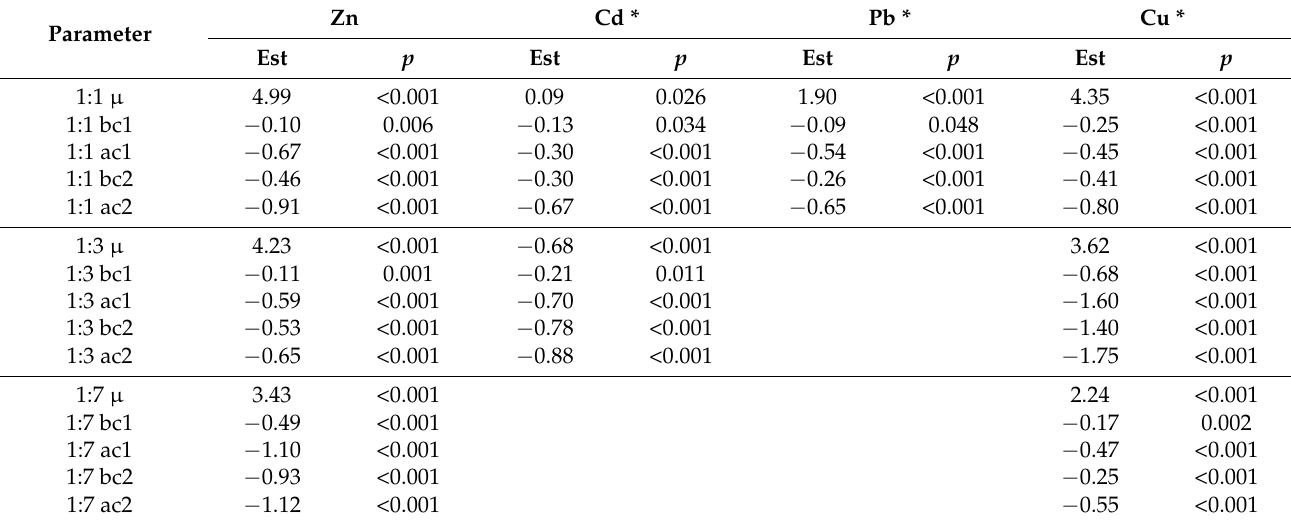
Table 8. GLM model parameters describing the influence of applied coal doses on metal form concentration after 1 M NH 4 NO 3 extraction for a given soil